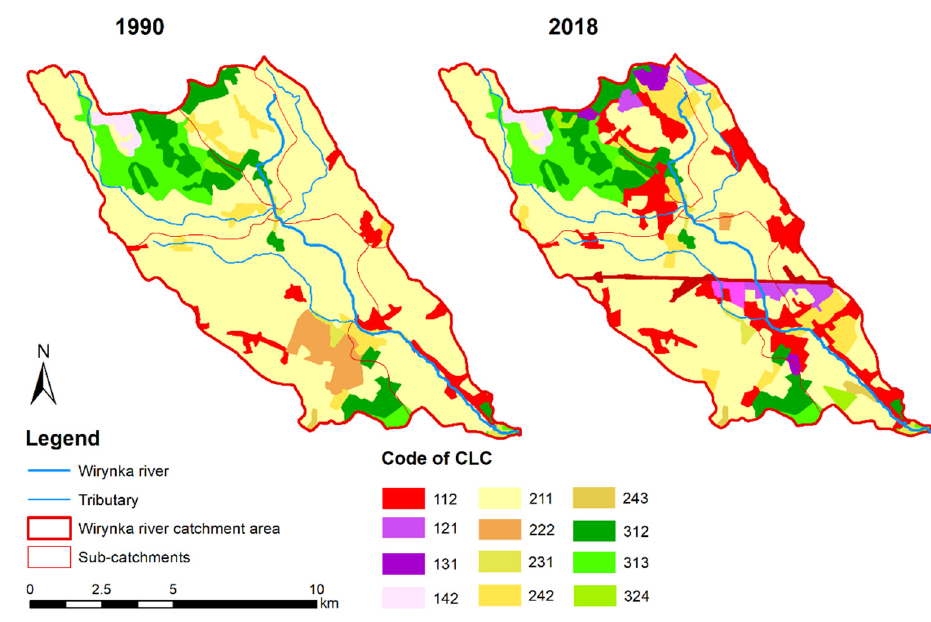
Figure 5. Land use of the Wirynka sub-catchment for two years (1990 and 2018).